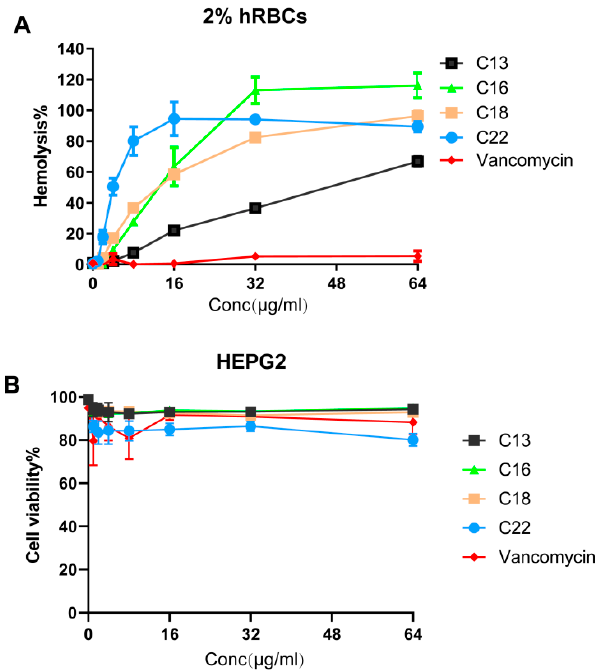
Figure 4. The hemolytic and cytotoxic effects of Cec4-derived peptides. ( A ) The hemolysis of human red blood cells (hRBCs) indicated that the HL 50 of the C13, C16, C18 and C22 peptides were 48, 16, 16, and 4 µg/mL, respectively. Vancomycin was used as a negative control. ( B ) Cellular toxicity of the peptide against liver-derived HepG2 cell lines showed that the LD 50 of all tested peptides were >64 µg/mL.